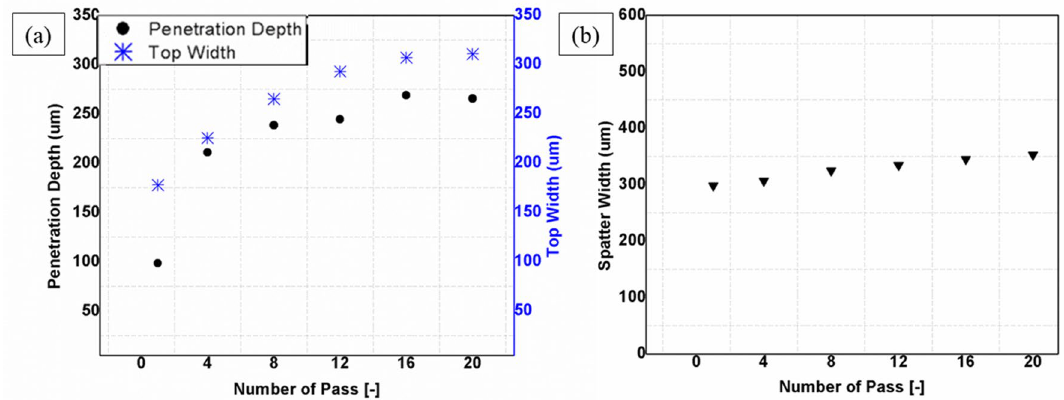
Figure 11. Effect of number of passes at fixed values of 20 kHz, 20W and 20 mm/s; ( a ) Effect on top width ( b ) Effect on spatter width [Fixed: 20 kHz, 20W, 200 ns and 100 mm/s].